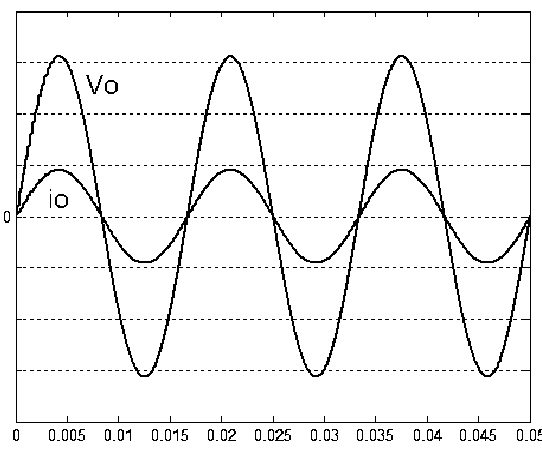
Figure 3. Output voltage and current for simulation of the conventional limited-time convergent VSC at full load (vertical: 50 V/div and 15 A/div).